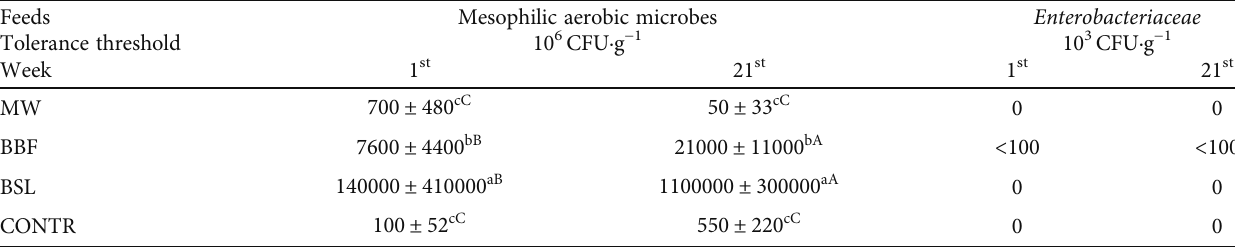
Table 6: Microbiological evaluation of the diets during the storage period (CFU · g − 1 feed).